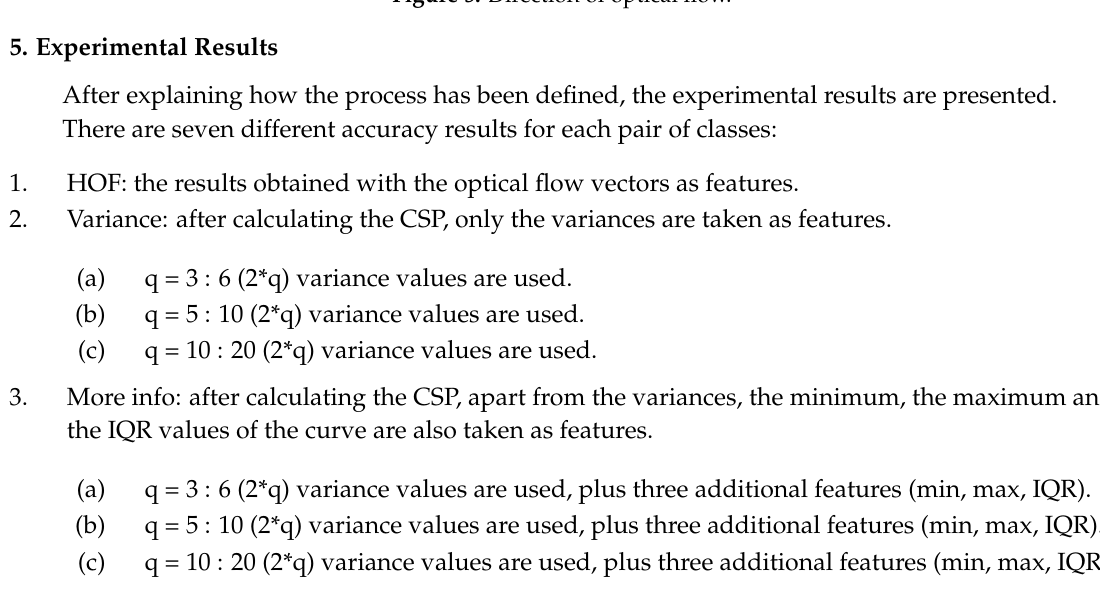
Figure 5. Direction of optical